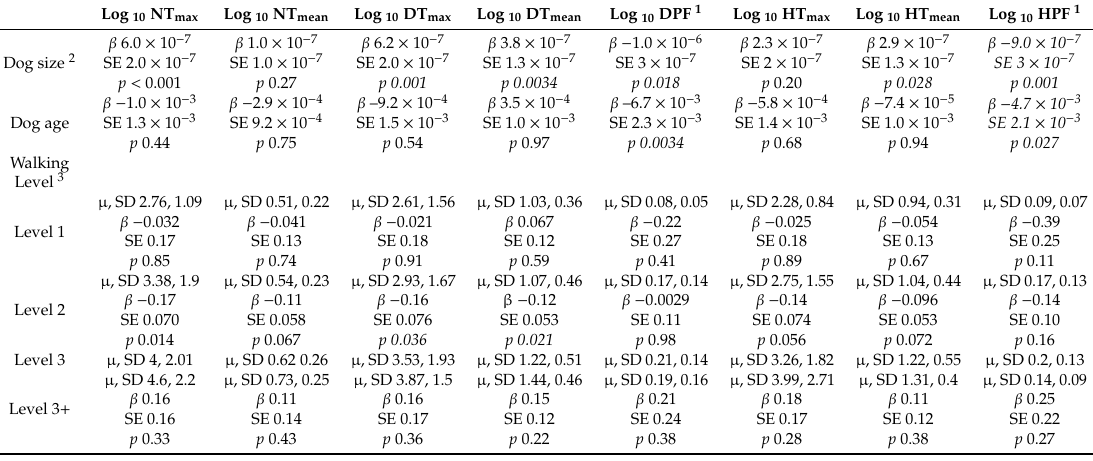
All dependent variables were entered into generalized linear mixed model using log 10 transformation.